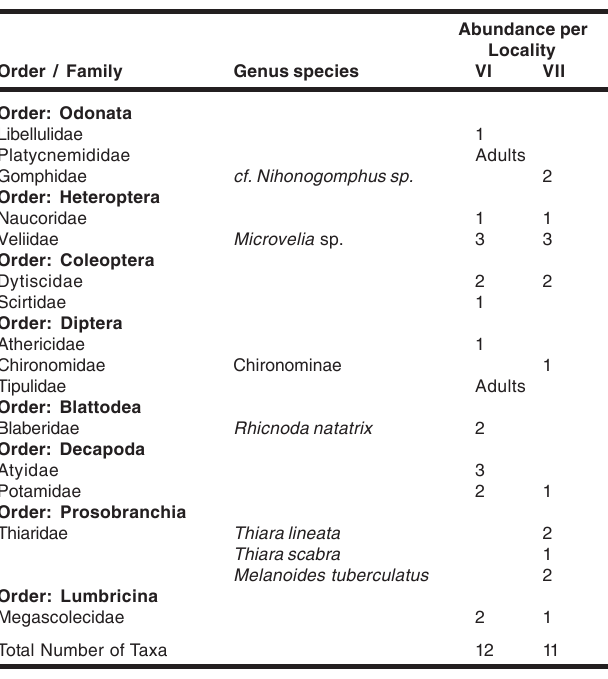
Table 4. Macro-invertebrate fauna of different Rhicnoda - habitats in India (Pench).